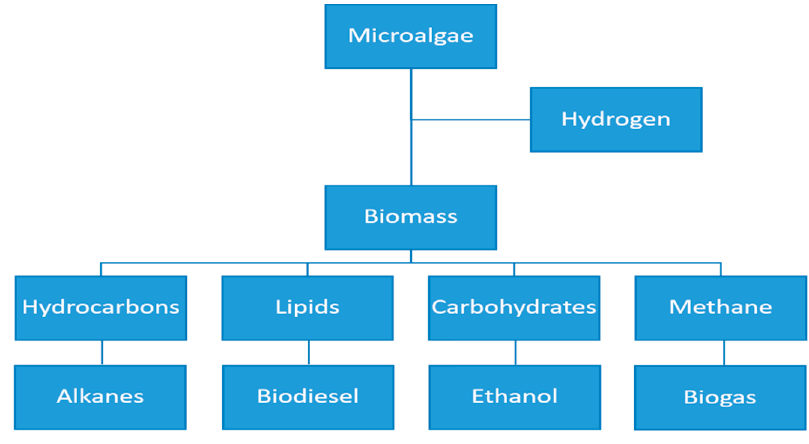
Figure 5. Fuel products derivable from microalgae.